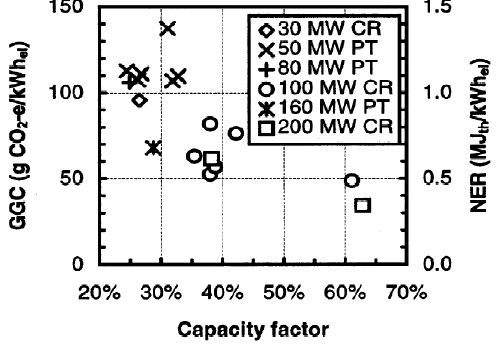
Figure 67. Greenhouse gas and energy intensities of Concentrating Solar Power as a function of average capacity factor (CR = Central Receiver, PT = Parabolic